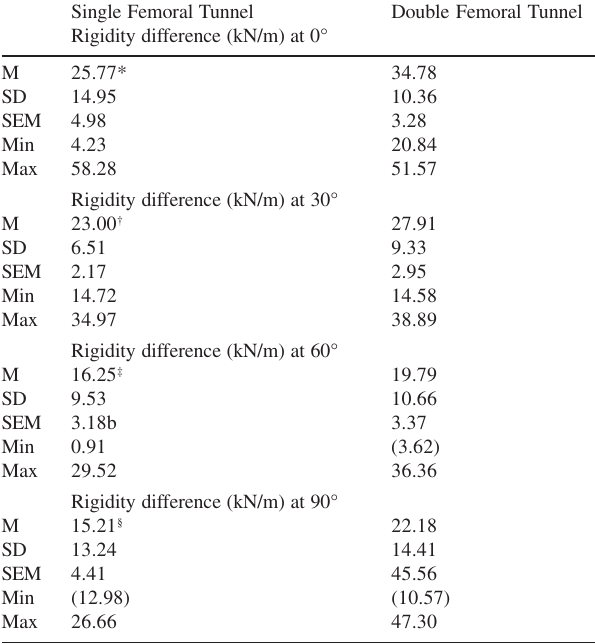
Table 4 - Difference between rigidity before (intact ligament) and after anterior cruciate ligament (ACL) reconstruction at 0°, 30°, 60°, and 90° of flexion in knees subjected to the technique using single and double femoral tunnel Single Femoral Tunnel Double Femoral Tunnel Rigidity difference (kN/m) at